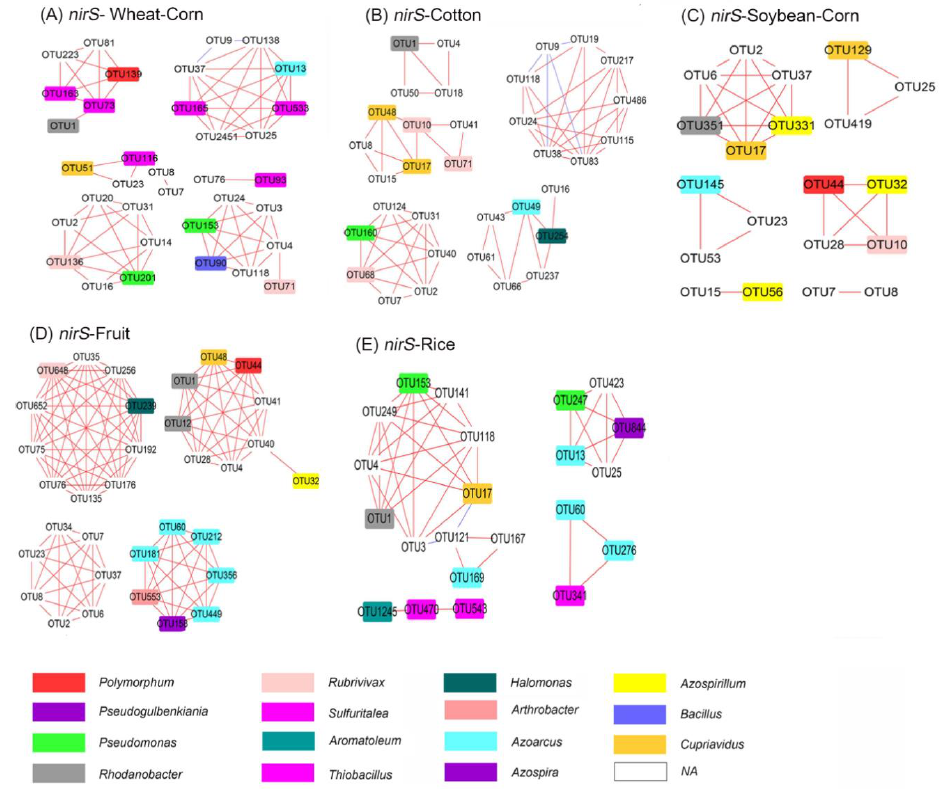
Figure 8. Network analysis of nirS -denitrifier OTUs in the five ecosystems: ( A ) Wheat–Corn; ( B ) Cotton; ( C ) Soybean–Corn; ( D ) Fruit; ( E ) Rice. The network only shows the “dominant” OTUs with a relative abundance > 0.5% in at least one replicate. Red solid lines: significantly positive relationships (Pearson correlation r > 0.85); blue solid line: significantly negative relationships (Pearson correlation r < −0.85).